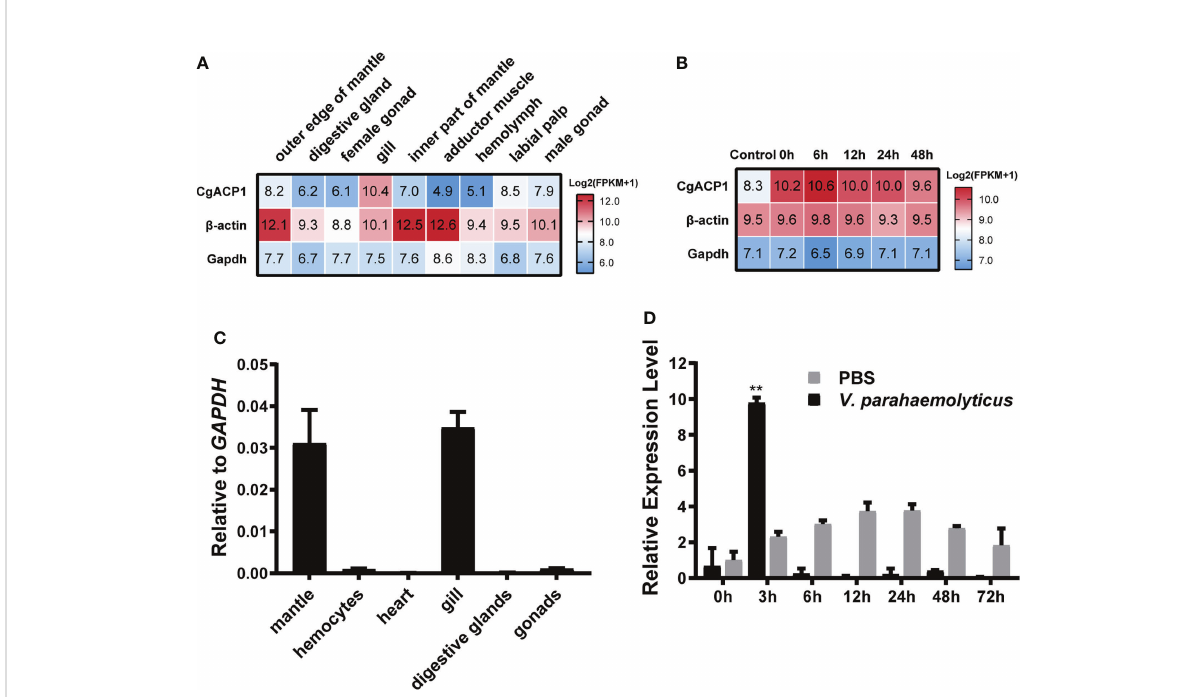
FIGURE 3 The expression patterns of the CgACP1 gene. (A) The CgACP1 mRNA expression in different tissues based on the RNA-seq data from NCBI BioProject PRJNA146329 (31). The raw expression data are provided in Supplementary Table 3. (B) The CgACP1 mRNA expression in the gill before and after Vibrio challenge based on the RNA-seq data from NCBI BioProject PRJNA194079 (32). The raw expression data are provided in Supplementary Table 4. (C) Real-time quantitative RT-PCR analysis of the relative mRNA expression of CgACP1 in different tissues. (D) Real-time quantitative RT-PCR analysis of the relative mRNA expression of CgACP1 in the hemocytes before and after Vibrio challenge. The qPCR-based expression data were shown as a ratio to the gapdh mRNA expression and were plotted as the mean ± SD. ** p < 0.01 versus mRNA level at 0